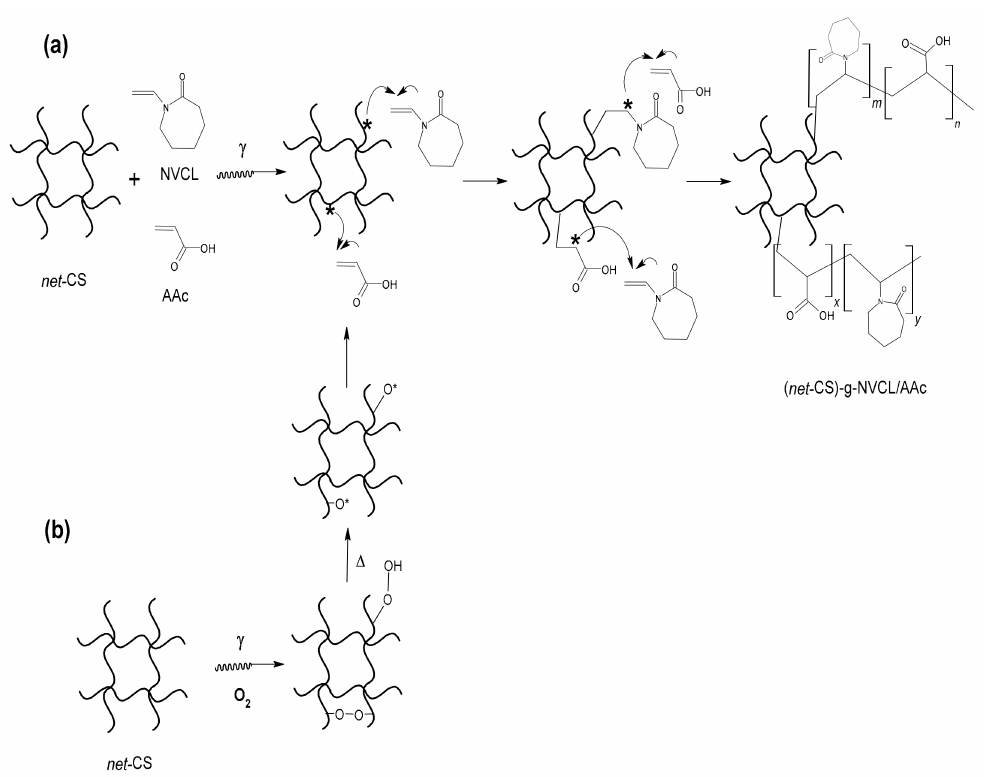
Figure 3. ( a ) Direct method and ( b ) oxidative pre-irradiation method for radiation grafting polymer-